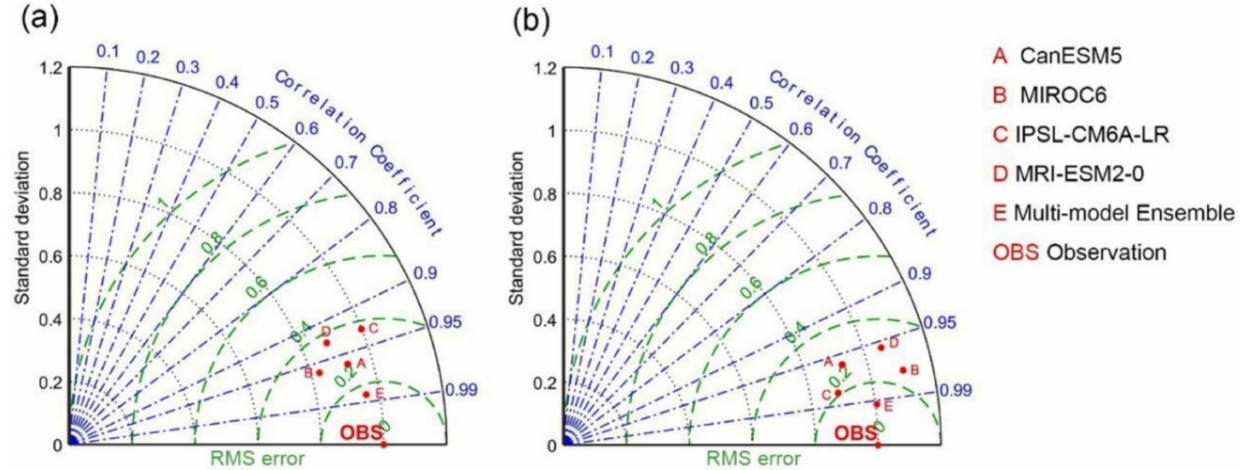
Figure 1. Taylor diagram of ( a ) annual mean temperature and ( b ) annual total precipitation for CMIP6 outputs, muti-model ensembles, and climate observations (1961–2014) in